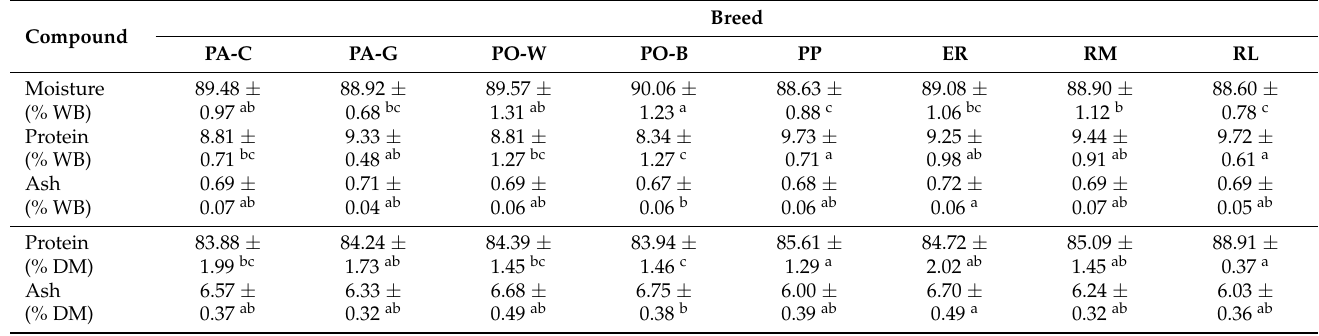
Table 1. Least-squares means and standard error of composition of albumen for the breed effect.